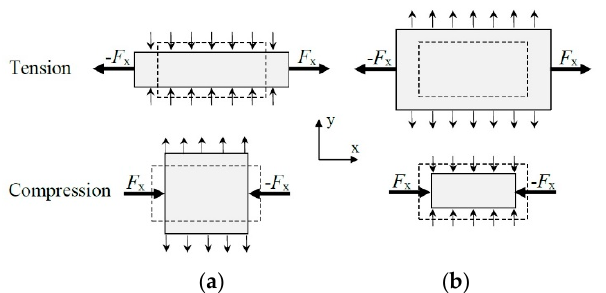
Figure 1. Non-auxetic ( a ) and auxetic ( b ) behavior during tensile and compressive loading (dashed lines—undeformed geometry)